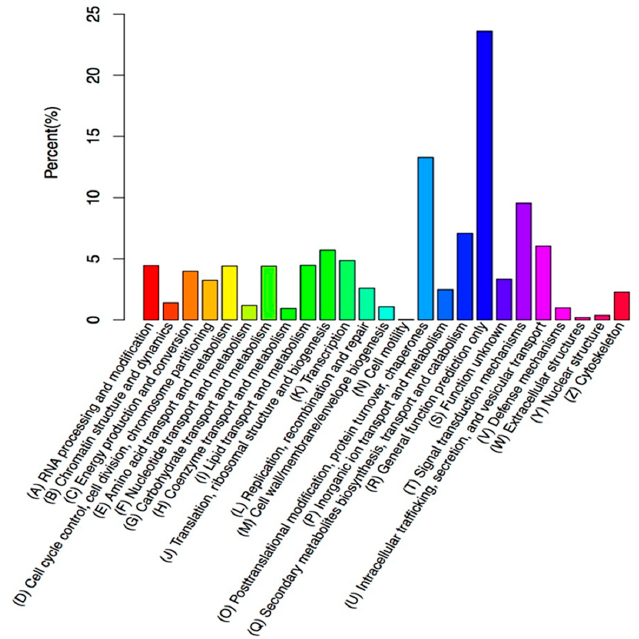
Figure 5. KOG annotation of putative proteins. Totally, 16,393 putative proteins in 25 specific categories.